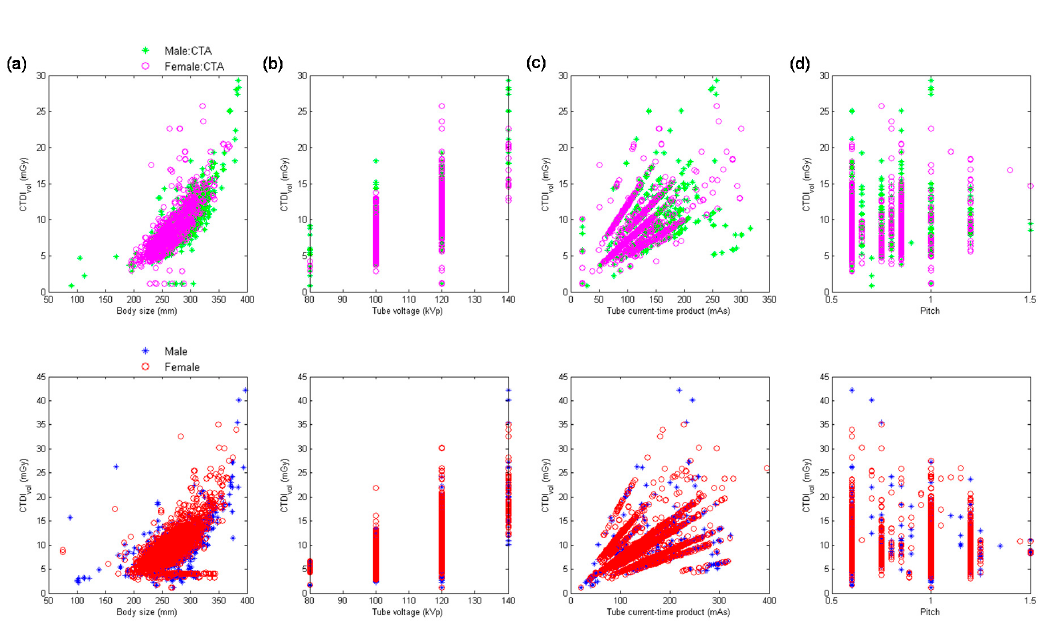
Figure 3. Scatter plots of CTDI vol versus ( a ) body size, ( b ) kVp, ( c ) mAs, and ( d ) pitch for abdominal CTA scans ( upper row) and abdominal scans excluding CTA ( lower row) performed using MDCT 64 . Table 6. Results of multivariate analysis for the abdominal scans performed using MDCT 64 .